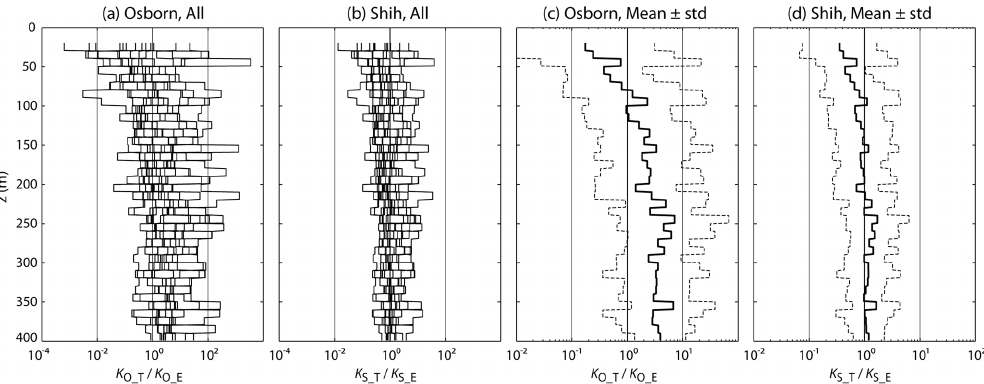
Figure 5. Ratio profiles of the Thorpe-scale-derived diffusivities and the TurboMAP-derived diffusivities at all intercomparison stations based on (a) the Osborn parameterization and (b) the Shih parameterization. Here, the R o = 0 . 25 criterion is commonly used. (c) and (d) are the same as (a) and (b) but for the mean (black) and standard deviation (grey) of all